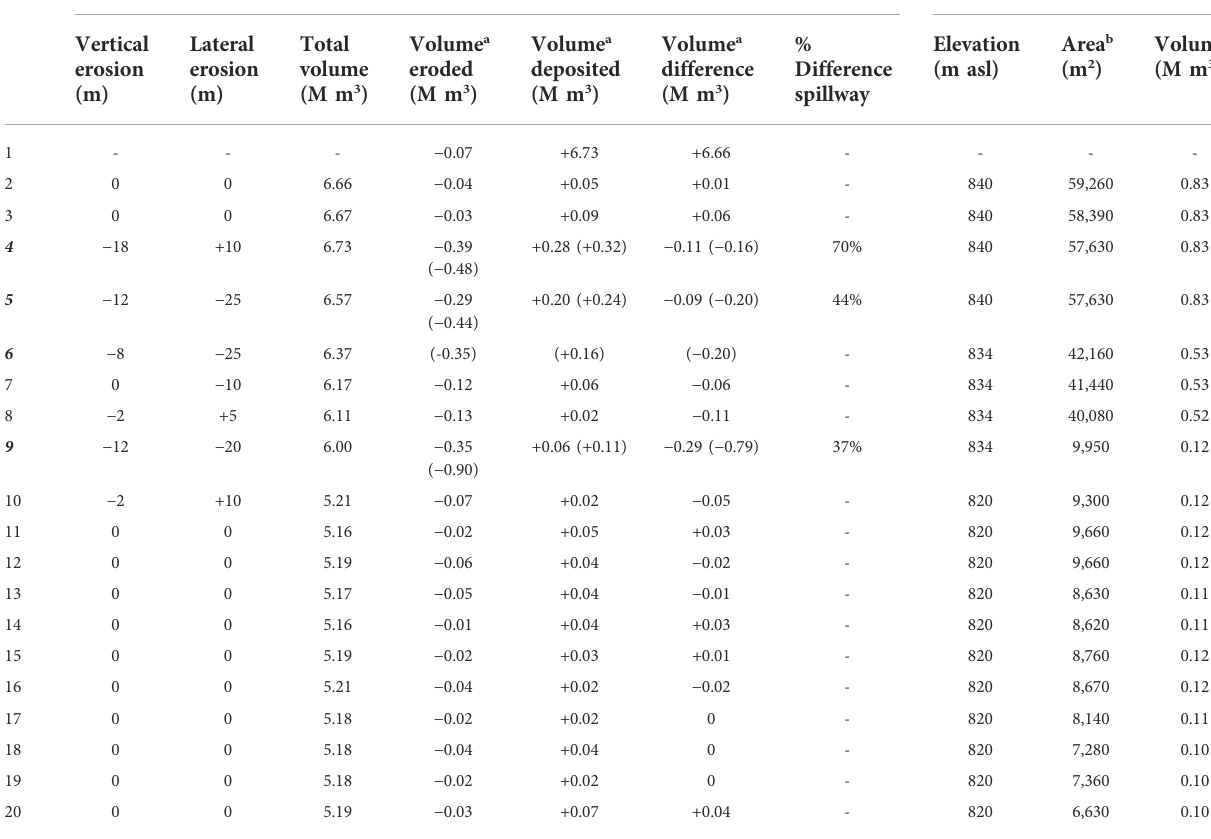
TABLE 3 Changes to the HRA dam and lake documented in the remote sensing datasets (see also Figure 7, Table 1). DM, difference model, and bold italicised numbers represent major erosion events (see text). Vertical and lateral erosion of the dam refer to incremental changes in pro fi le B-B ’ (Error! Reference source not found.),measuredfrom thelowest pointineachepoch (correspondingtostream thalweg after erosion ofthe Spillway). Volume changes are derived from 3D point cloud-to-point cloud and 2D raster comparison bracketing each of the four major erosion events. The % difference is how much of the volume difference in each erosion event occurred in the Spillway. Lake elevation is